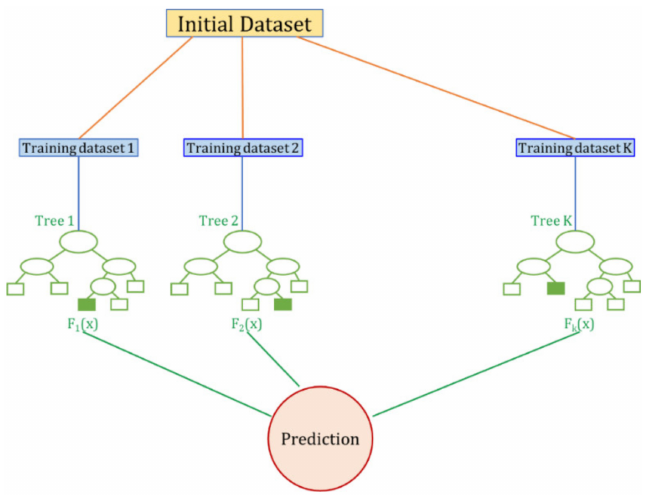
Figure 2. Typical architecture of the Random Forest